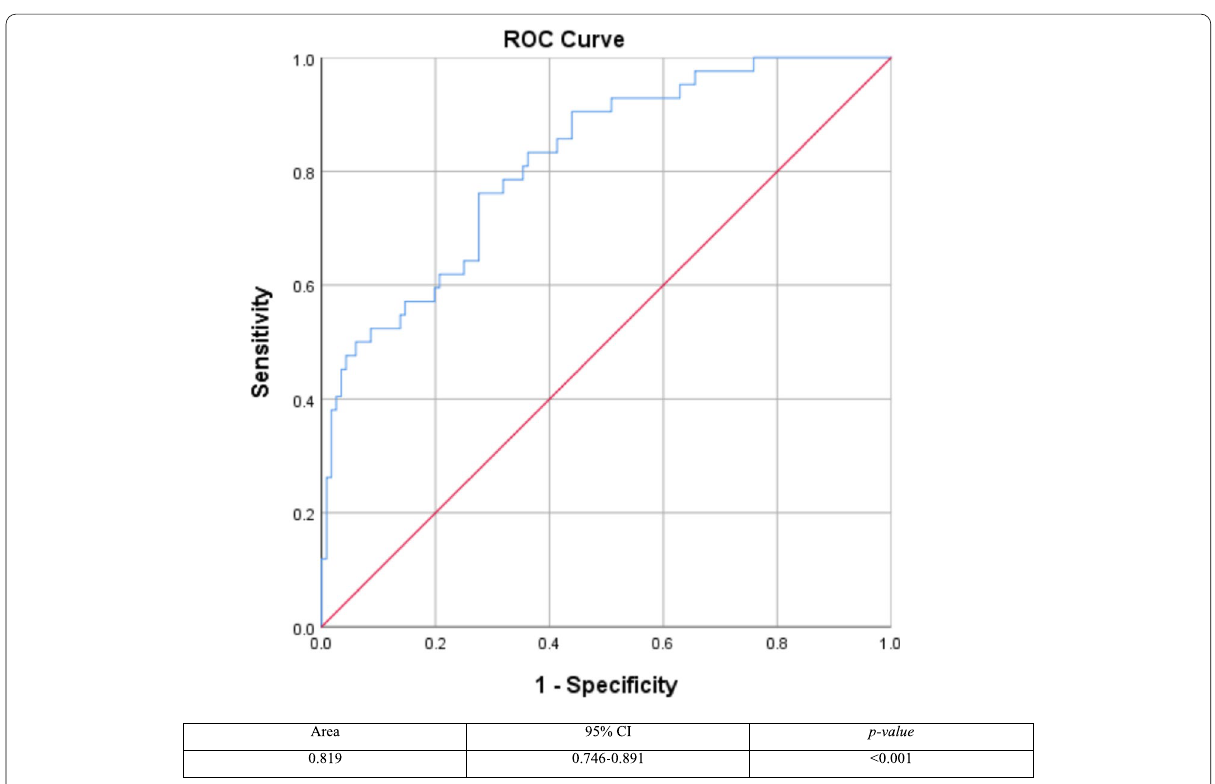
Fig. 1 The ROC curve